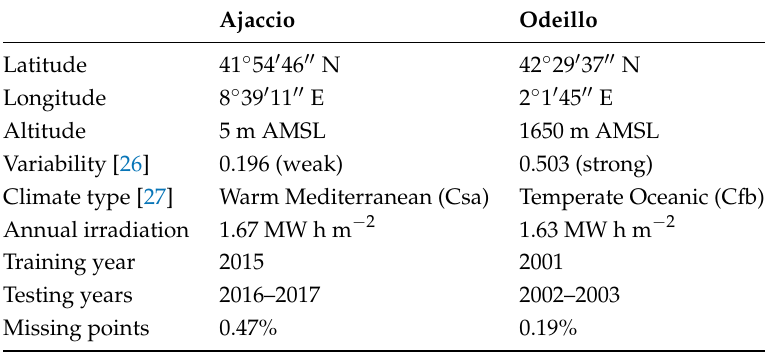
Table 1. Test sites and global solar irradiance time series